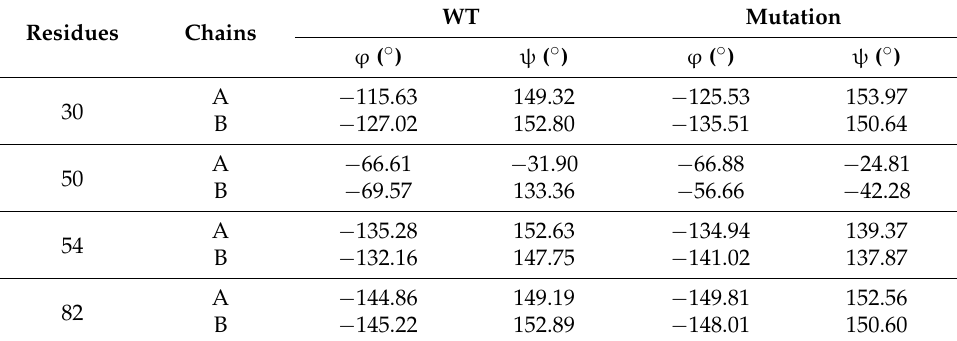
Figure 3. Contour maps of the free energies as a function of the backbone angles ψ and ϕ for residue 50 in WT ( A , B ) and I50V ( C , D ). ( A ) and ( C ) are in chain A, as well as ( B ) and ( D ) in chain B. Table 1. The averaged backbone angles of mutated residues.